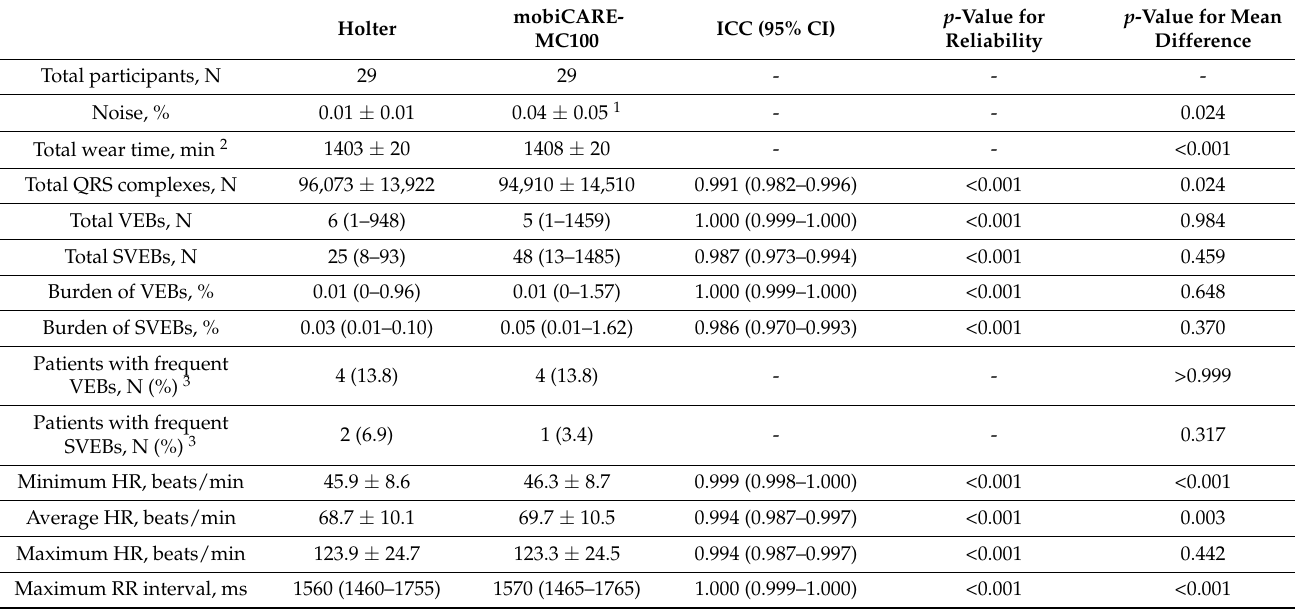
Both monitoring methods had noise sections of less than 0.1% of the total monitoring period. The MC-100 showed a negligible amount of noise sections (0.04 ± 0.05% of total recording time), but which was significantly higher than the 24 h ECG monitoring Table 3. Comparisons of ECG monitoring between Holter and adhesive single-lead ECG monitoring for the study population. p -Value for p -Value for Mean mobiCARE- Holter ICC (95% CI) MC100 Reliability Difference Total participants,